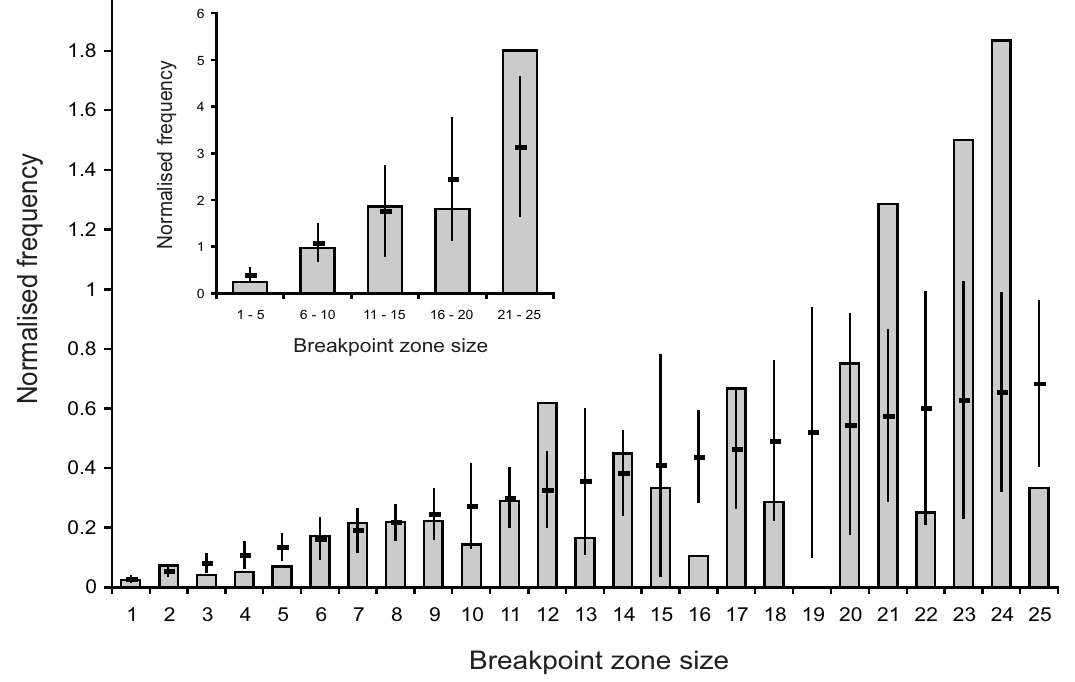
Figure 2. The significance of local sequence identity to recombination. The main plot displays the normalized distribution of in vitro breakpoints falling within zones ranging from size 1 to 25 (vertical grey bars); see Baird et al. [21] for further details. The horizontal lines indicate the expected random distribution of breakpoints for the zones. The inset plot shows the normalised frequency of both the in vitro breakpoints and randomly generated breakpoints for zones up to size 25 (arranged in groups of five). On the main plot, error bars on the random distributions (vertical lines) represent one standard error to include 68.3% of the distribution. On the inset, the error bars on the random distributions represent 1.96 6 standard error to include 95% of the distribution.